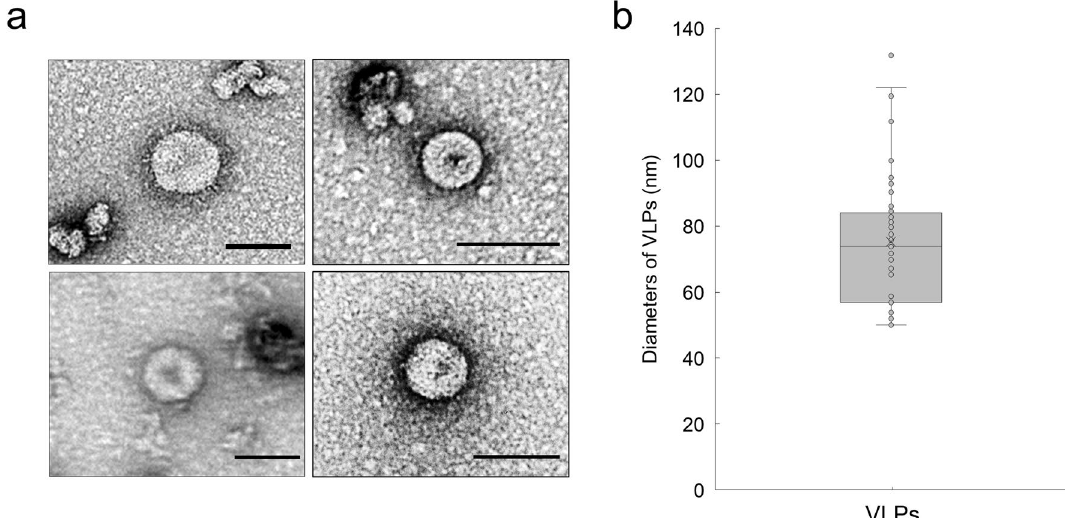
Figure 3. Electron microscopic analysis of plant-derived CoV-2 VLPs. ( a ) Visualization by 1.2% UA negative staining and high-resolution electron microscopy of purified VLPs of ME + N FLAG . Scale bar 100 nm. ( b ) Quantification of diameters of plant-derived CoV-2 VLPs. VLPs ranged from 50 to 130 nm in